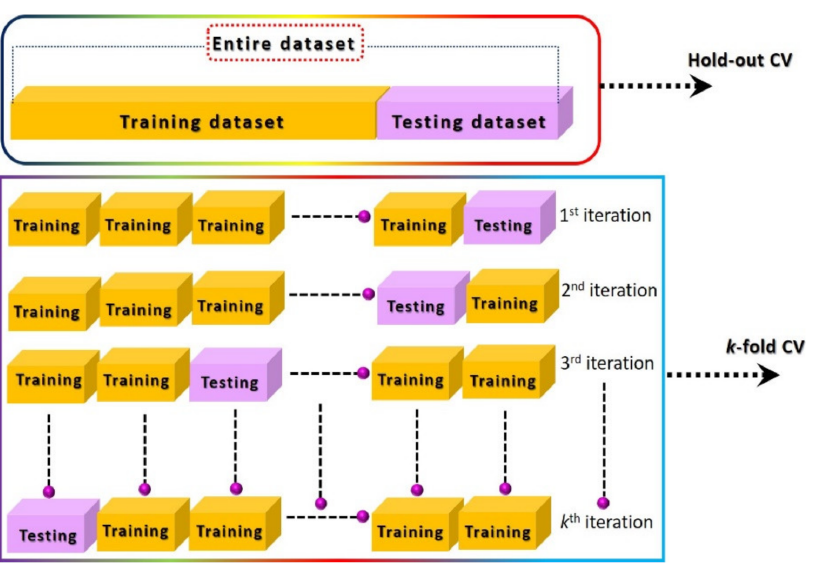
Figure 11. Illustration of hold-out and k -fold cross-validation techniques.